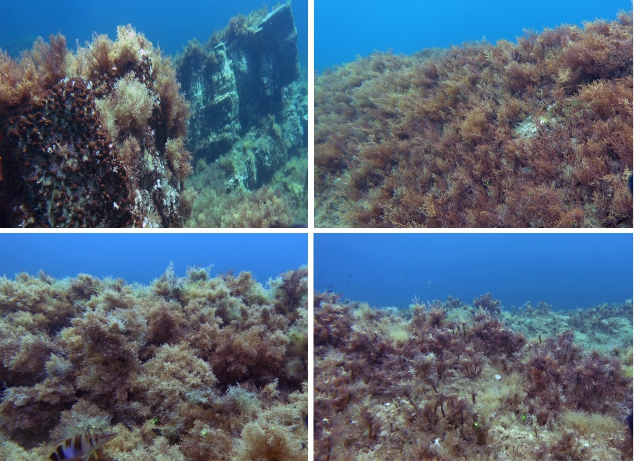
Figure 4. Cystoseira s.l. forests covering the Cilento Flysh of the Santa Maria di Castellabate